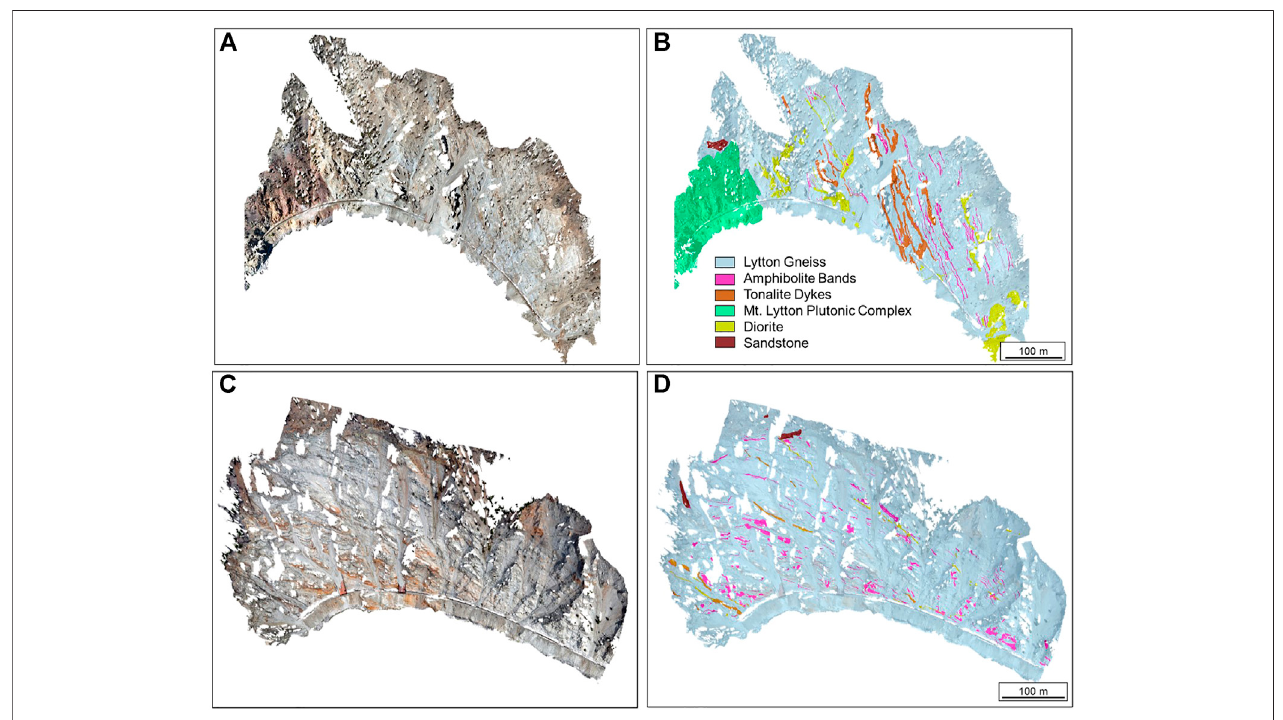
FIGURE4| Overviewofthelithological unitspresent intheWC. (A) RGBphotogrammetry modelofWCW; (B) geologicalmapofthemajorunitsinWCW; (C) RBG photogrammetry model of WCE; and (D) geological map of the major units in WCE. Note that the legend is the same for (B,D) and does not imply age of the units.